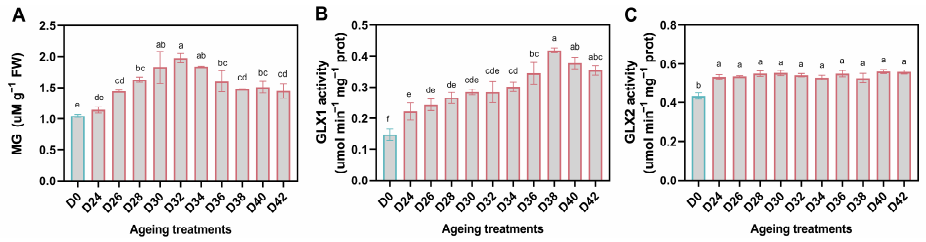
Figure 6. The change in MG content ( A ) and Glyoxalase activity ( B , C ) in oat seeds subjected to aging treatment. The letters represent statistical significance among the treatments and the vertical bars represent the ± SEM at p < 0.05 level for three replicates. The mean values sharing same letters, obtained from Duncan test, are not different significantly.